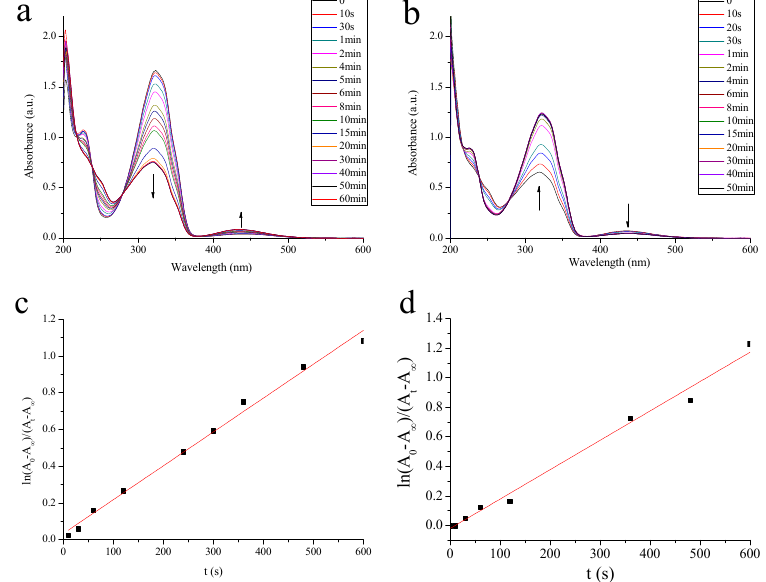
Figure 1. The ultraviolet–visible (UV-Vis) spectra and spectral changes of the 4-Methacryloyloxy Azobenzene (MAA). ( a ) Irradiation at 365 nm; ( b ) irradiation at 440 nm; ( c ) kinetics of the trans to cis photoisomerization; (d) kinetics of the cis to trans photoisomerization. a.u.: arbitrary units.